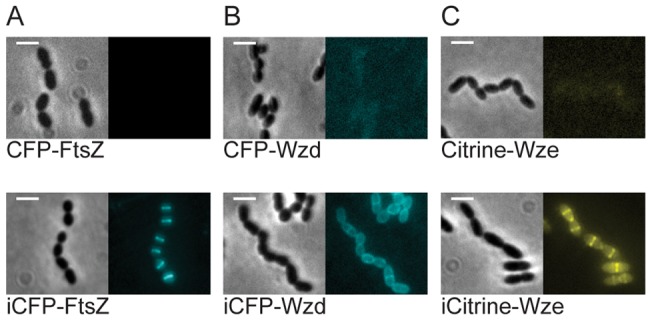
Applications of the developed tools for localization of S. pneumoniae proteins.(A) Localization of the cell division protein FtsZ as a N-terminal fusion to CFP (CFP-FtsZ, strain BCSMH050) and to i-tagged CFP, (iCFP-FtsZ, strain BCSMH051). (B) Localization of the membrane Wzd protein as a N-terminal fusion to CFP (CFP-Wzd, strain BCSJF004) and to improved i-tagged CFP, (iCFP-Wzd, strain BCSJF003). (C) Localization of the Wze tyrosine kinase as a N-terminal fusion to Citrine (Citrine-Wze, strain BCSJF002) and to improved i-tag Citrine (iCitrine-Wze, BCSJF001). The i-tagged versions of the fluorescent reporters allowed the visualization of each protein at the expected sub-cellular region of bacteria, the division septum. Exposure times: 5 sec. Scale bar: 2 μm.